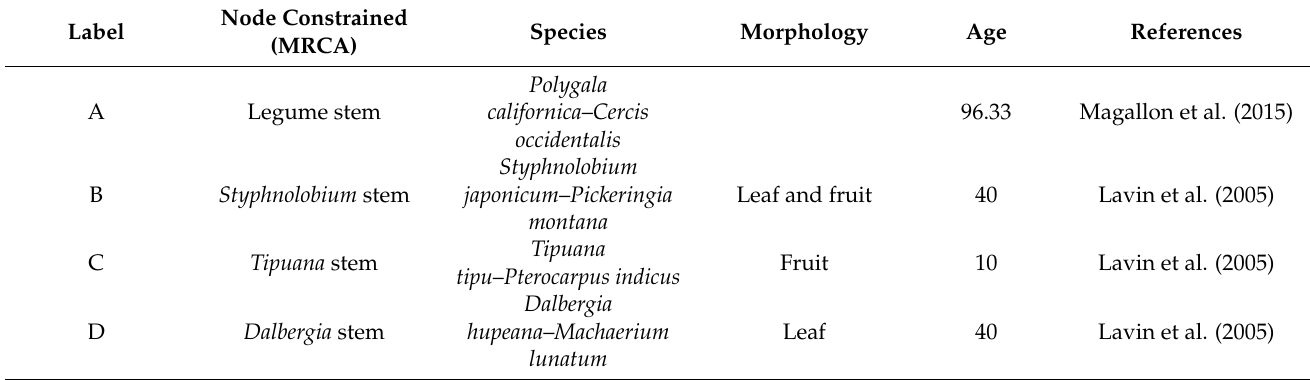
Table 1. Fossils used as calibration points to generate a time-calibrated phylogenetic tree of Dal- bergia . All ages in millions of years (Ma) and set to a minimum, except for Label A which was set to a